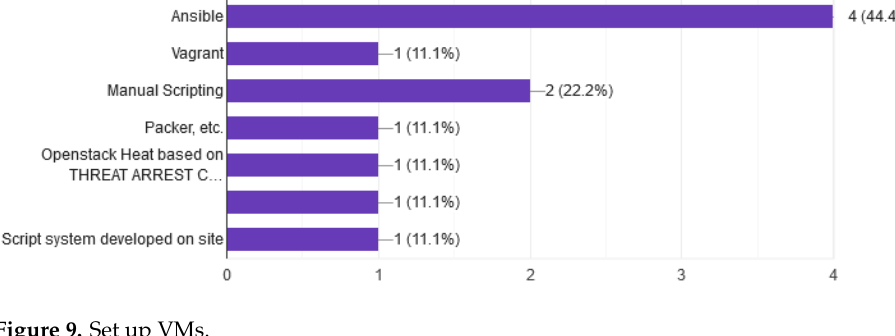
Figure 9. Set up